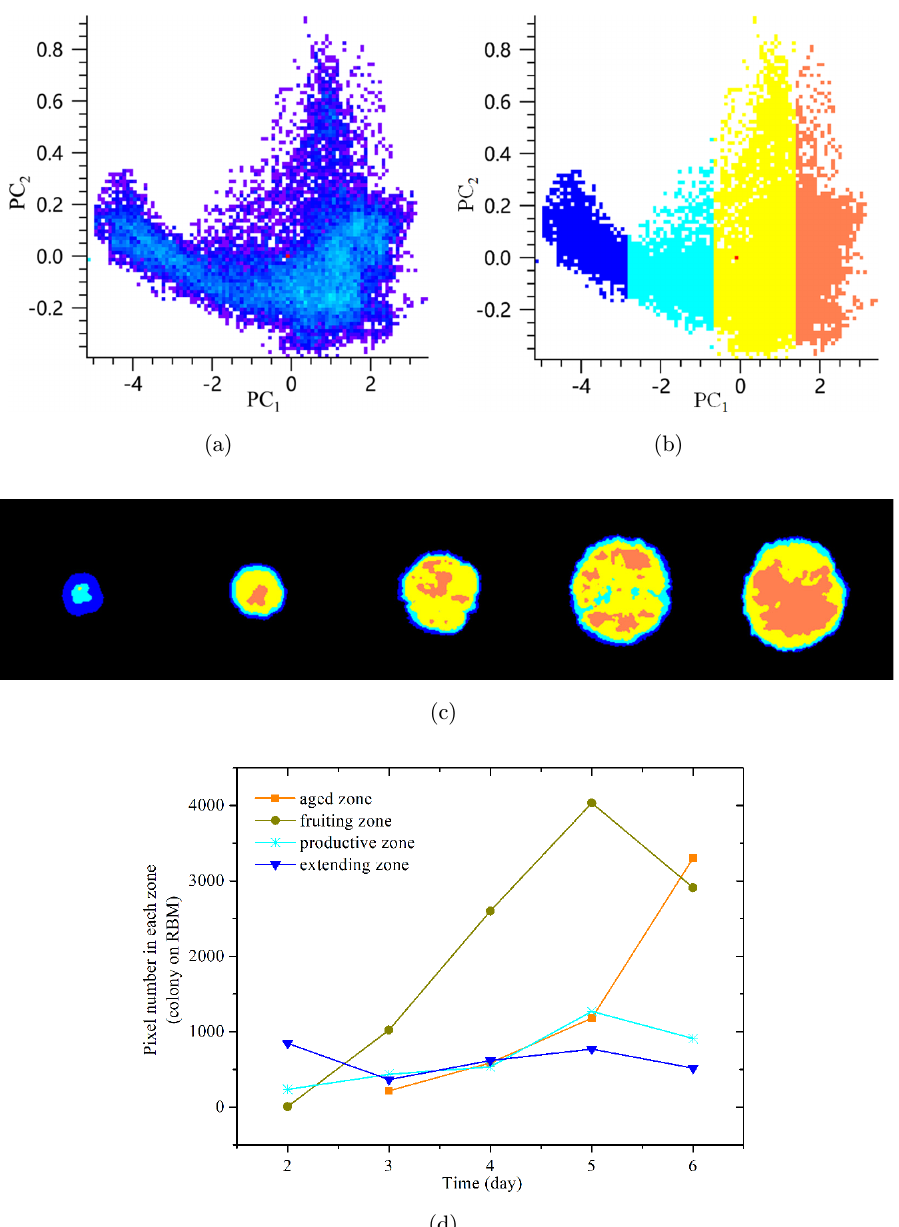
Fig. 5. Analysis of growth zones on colonies. (a) Score plot of PC 1 and PC 2 . (b) Grouping pixels with similar score values along PC 1 . (c) Projection of pixels groups onto image space. Blue is edge region; cyan is the area close to the edge; yellow is surrounding the center; coral is center of the colony. (d) Growth curve of each